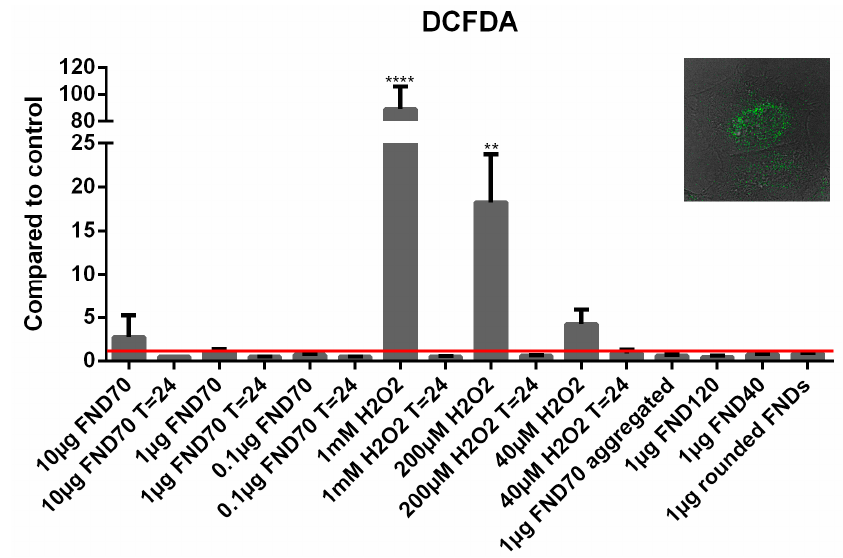
Figure 4. Mean free radical production. ROS production can be measured by the conversion of DCFDA to DCF. The more DCF there is, the higher the fluorescent signal a sample emits. As expected, adding a high concentration of hydrogen peroxide increases the signal drastically (up to 100-fold). All diamond samples do not alter the total free radical production inside cells. HeLa cells without a stimulant were used as a negative control to relate all values to. ** p < 0.01, **** p < 0.0001. Error bars show the standard deviation. The inset in this figure shows a cell in greyscale with the metabolized DCF in green.